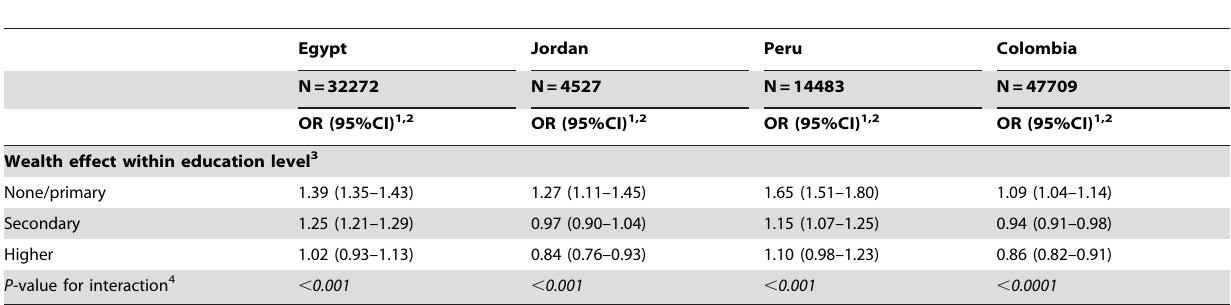
Table 6. Effect of wealth on obesity within three education levels in the middle-income countries, DHS data.